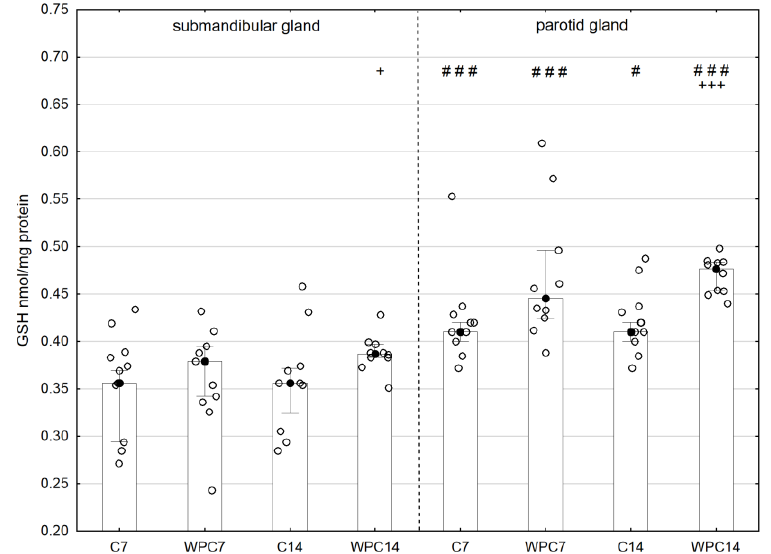
Figure 5. Reduced glutathione (GSH) content in the salivary glands of rats from control and experimental groups. Abbreviations: C7, C14, control groups; WPC7, WPC14, experimental groups treated WPC-80; GPx, glutathione peroxidase. Data are presented as a bar chart with the individual